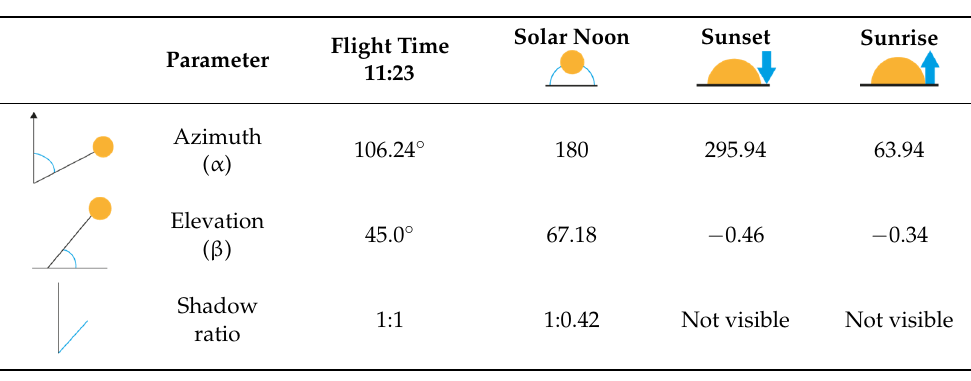
Table 1. Calculated solar azimuth, elevation and shadow ratio using NOAA Solar Calculator for the flight date, 29 July 2021, at 11:23, solar noon, sunset and sunrise (local time).